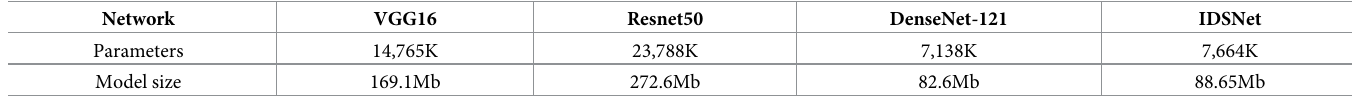
Table 5. Parameter and model size for the different CNN models used to test the BreakHis dataset.